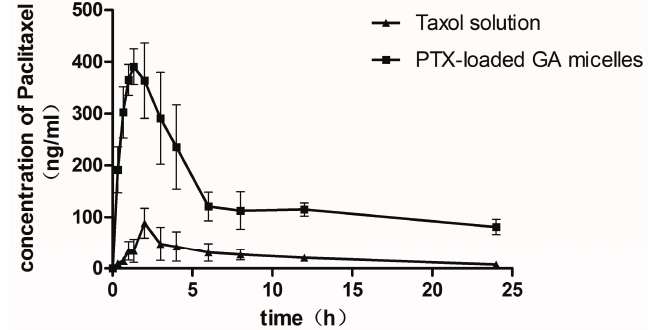
Figure 6. Mean plasma concentration-time profiles of paclitaxel following oral administration of paclitaxel at dose of 20 mg/kg of Taxol ® and PTX-loaded GA micelles. Each data presented as the Mean ± S.D. of 5 rats. Table 3. Pharmacokinetic parameters of PTX after oral administration or I.V